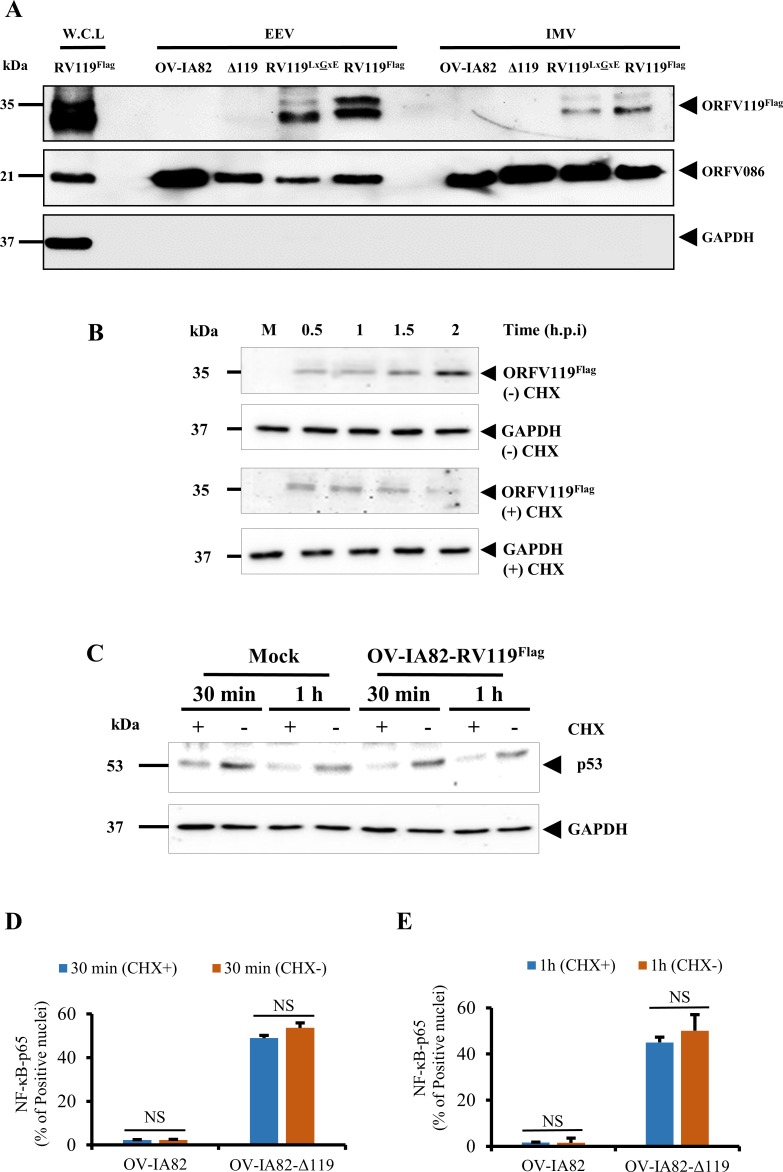
(A) Detection of ORFV119 or ORFV119LxGxE in virions. OFTu cells were infected with OV-IA82, OV-IA82-Δ119 (Δ119), OV-IA82-RV119LxGxE-Flag (RV119LxGxE) or OV-IA82-RV119Flag (RV119Flag) and IMV and EEV virions were purified as described in Materials and Methods. Whole cell lysate (W.C.L) (60 μg) from OV-IA82-RV119Flag infected OFTu cells, and purified virions (10 μg) were resolved by SDS-PAGE and analyzed by Western blot using antibodies against Flag, ORFV086 structural core protein (positive control) or GAPDH. Results are representative of three independent experiments. (B, C) Effect of translation inhibition on ORFV119 and control cellular protein p53 expression. OFTu cells mock treated or pre-treated with CHX (50 μg/ml) for 30 min were mock infected or infected with OV-IA82-RV119Flag (MOI, 10) in presence of the drug and harvested at 0.5 h, 1 h, 1.5 h, and 2 h p.i. Cell extracts (50 μg) were resolved by SDS-PAGE, blotted, and probed with anti-Flag, anti-p53 and anti-GAPDH antibodies. (D, E) OFTu cells were drug treated and infected as in B with OV-IA82 or OV-IA82-Δ119 viruses, fixed at 30 min (6D) or 1 h p.i (6E), incubated with anti-NF-κB-p65 antibody, and examined by confocal microscopy. Cells were counted (n = 300 cells/slide) and results are shown as percentage of cells expressing nuclear NF-κB-p65. Results are mean values from two independent experiments. NS, non-significant by Student t test. [OV-IA82 (CHX+) vs OV-IA82 (CHX-), OV-IA82-Δ119 (CHX+) vs OV-IA82-Δ119 (CHX-)].